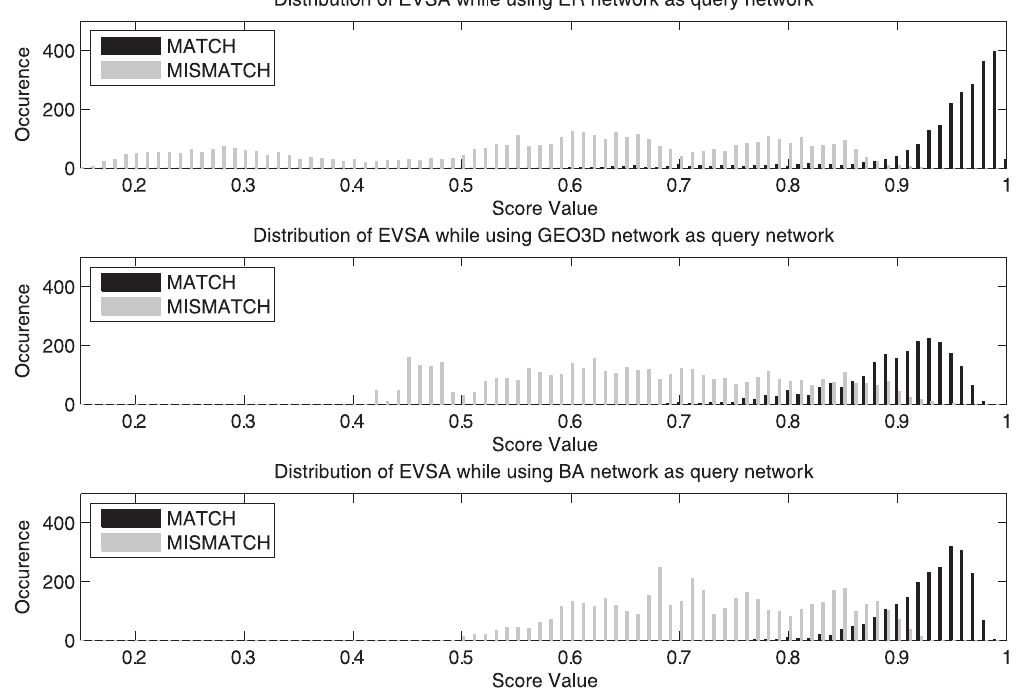
Figure 4. Sampled population of EVSA score. From top to bottom are a) ER network, b) GEO3D network, c) BA network as the query network used respectively.